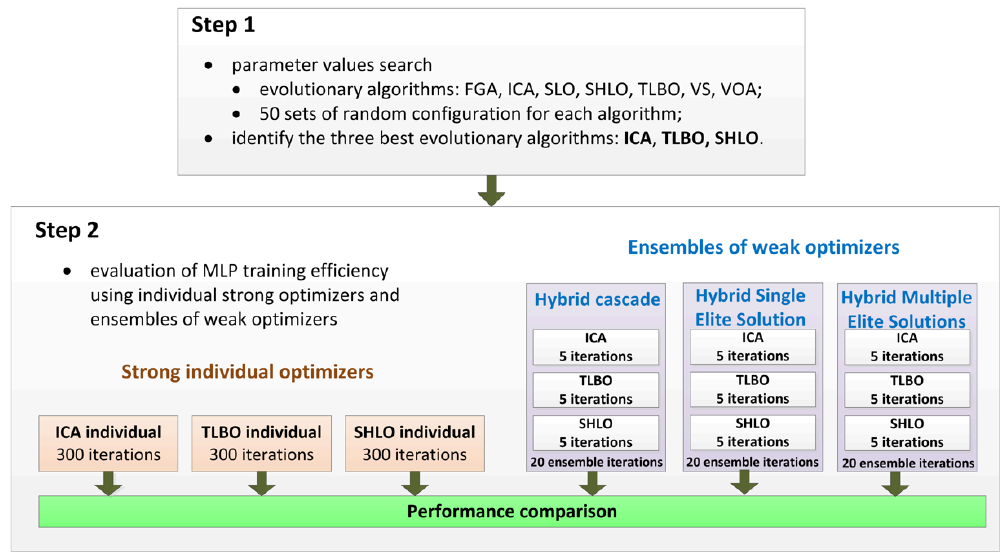
Figure 7. The experiment setup.